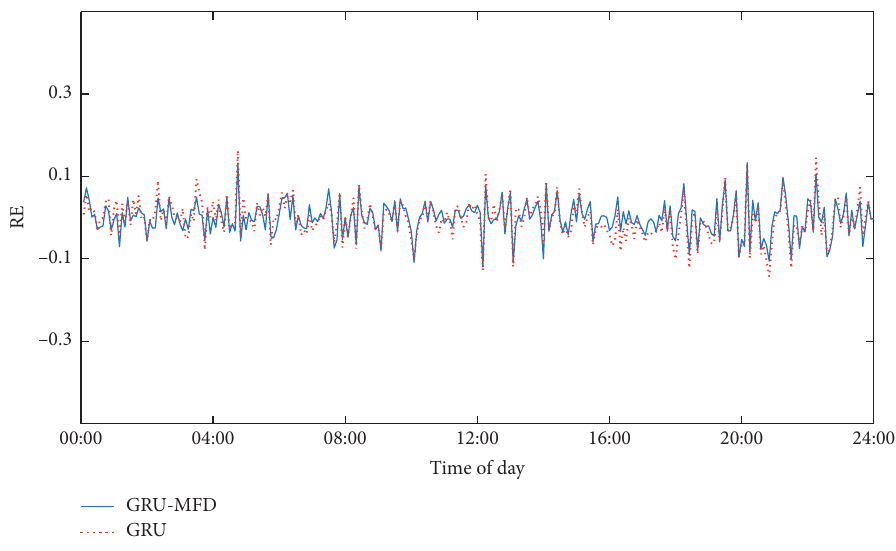
Figure 17: Errors on July 5, 2018, Section 1.